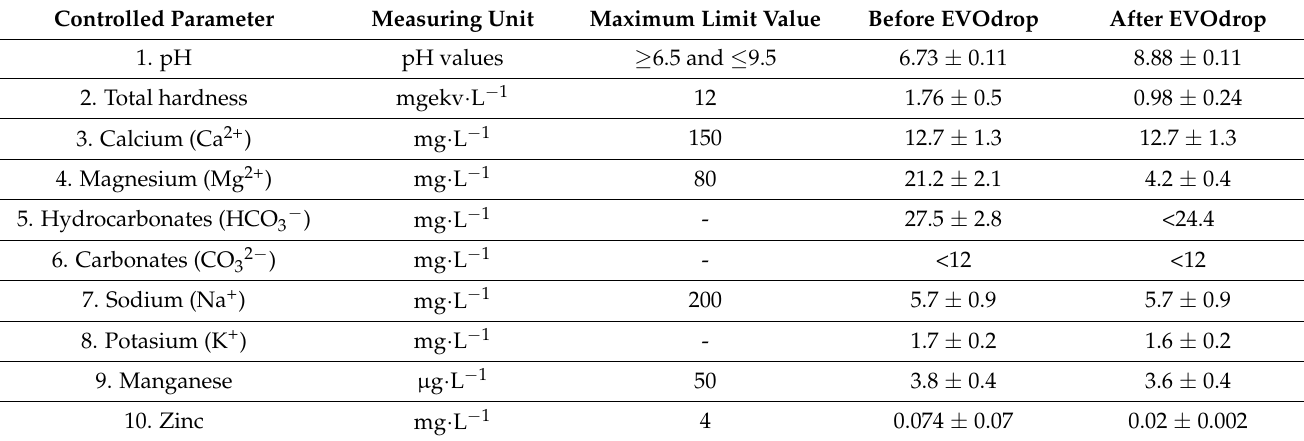
Table 3. Physicochemical parameters of the tap water from Germany before and after filtration with EVOdrop